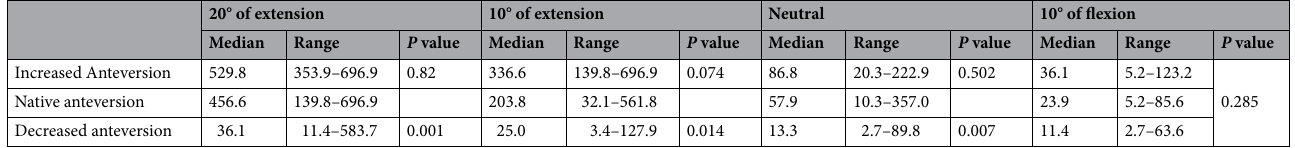
Table 3. Maximum surface pressure (kPa) of the iliopsoas muscle when stem anteversion was changed. Values are shown as the median and range. P value are from the Friedman test. For p values of < 0.05 in the